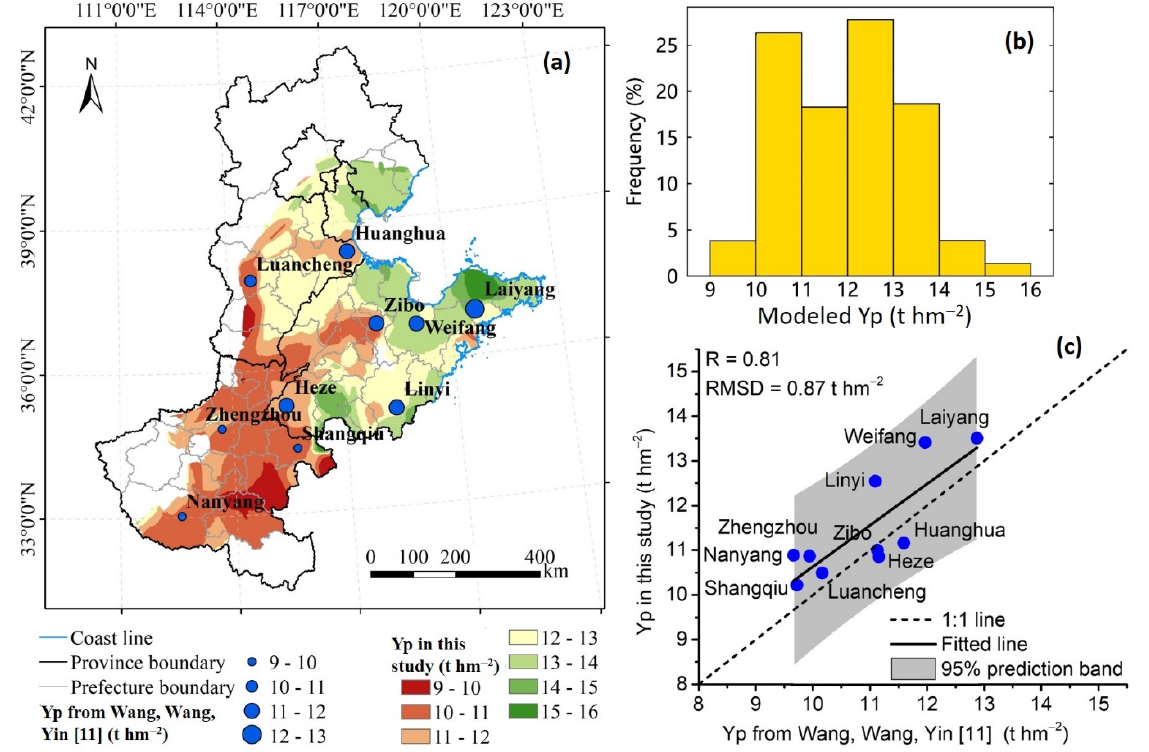
Figure 6. The map ( a ) and frequency distribution ( b ) of mean annual modeled Yp of summer maize over the period 2010 to 2015, and the modeled Yp of 10 agricultural meteorological (AM) sites vs. the simulations of corresponding sites from Wang, Wang, Yin, Feng and Zhang [11] ( c ). The value ranges in the legend of panel ( a ) are right-closed and left-open. Yp data from Wang, Wang, Yin, Feng and Zhang [11] represent the average of annual Yp in the period 1982 to 2005 for Linyi, 1982 to 2008 for Zibo and Laiyang, and 1982 to 2009 for the remaining sites.